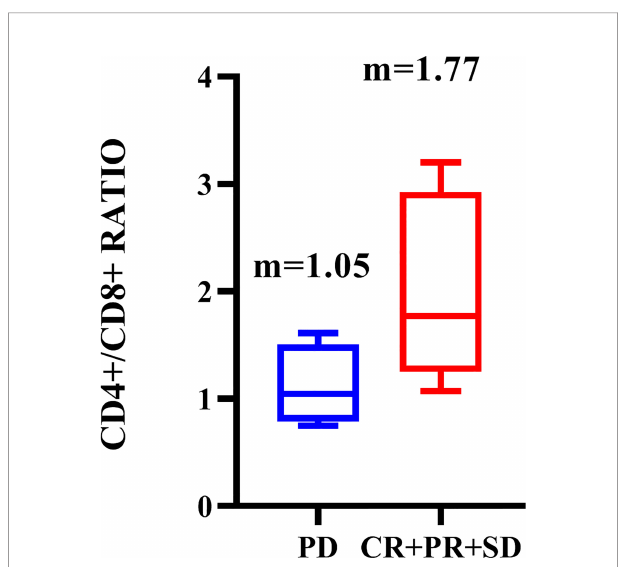
FIGURE 9 | Distribution of peripheral blood CD4+/CD8+ in CR/PR/SD subgroup and PD subgroup in patients receiving chemotherapy combined with immunotherapy. M is the median of each lymphocyte